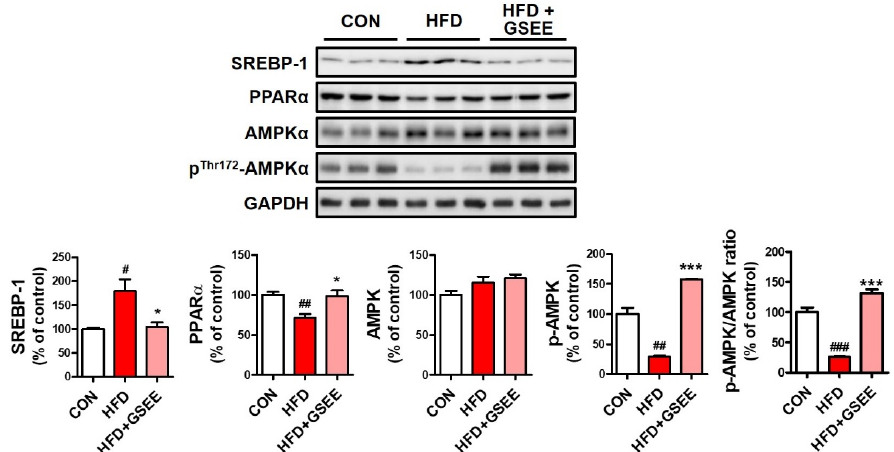
Figure 7. Effects of GSEE on the hepatic protein levels involved in lipid metabolism in HFD-fed mice: mice were fed with HFD for 10 weeks with or without daily oral administration of GSEE (45 mg/kg of body weight). Liver samples from randomly selected 3 mice in each group were used for Western blot analysis. Values are represented as mean ± SE. Student’s t -test, #, ##, ### p < 0.05, 0.01, and 0.001, respectively, vs. control. *, *** p < 0.05 and 0.001, respectively, vs.